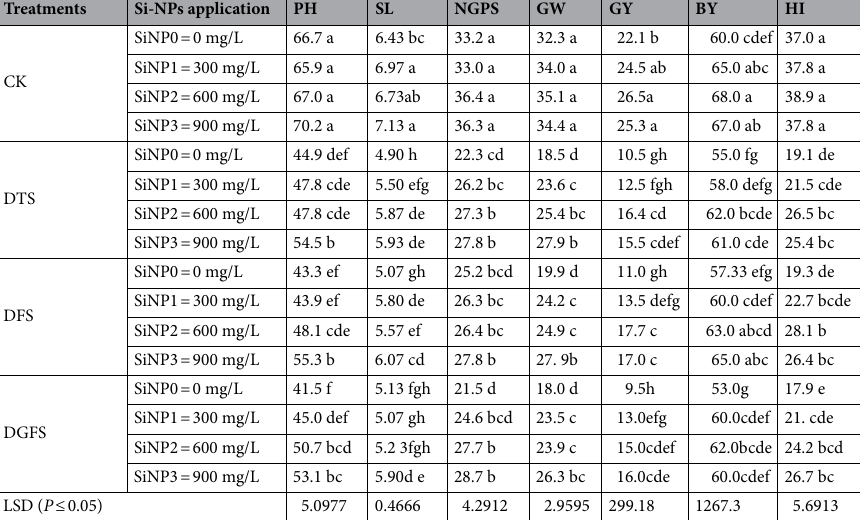
Table 2. Effects of Si-NPs on different parameters of wheat under drought stress. Plant height (PH, cm), spike length (SL, cm), number of grains per spike (NGPS), 1000-Grain Weight (GW, g), Grain Yield per Plant (GY, g), Biological Yield per Plant (BY, g), Harvest Index (HI) affected by Si-NPs application under drought stress conditions at different growth stages of wheat ( CK Control, DTS Drought at tillering stage, DFS drought at flowering stage, and DGFS Drought at grain filling